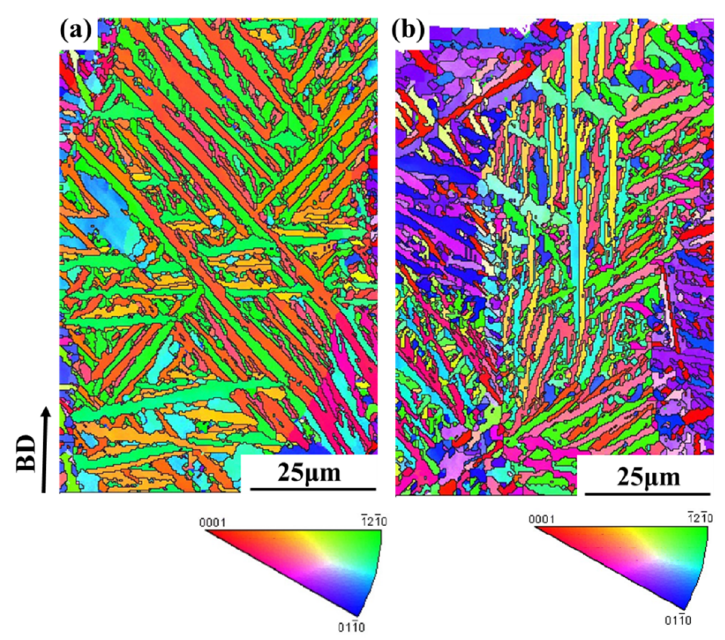
Figure 3. Electron backscattering diffraction (EBSD) maps of the cross-section for SLM-fabricated Ti64 samples before ( a ) and after ( b ) LSP.